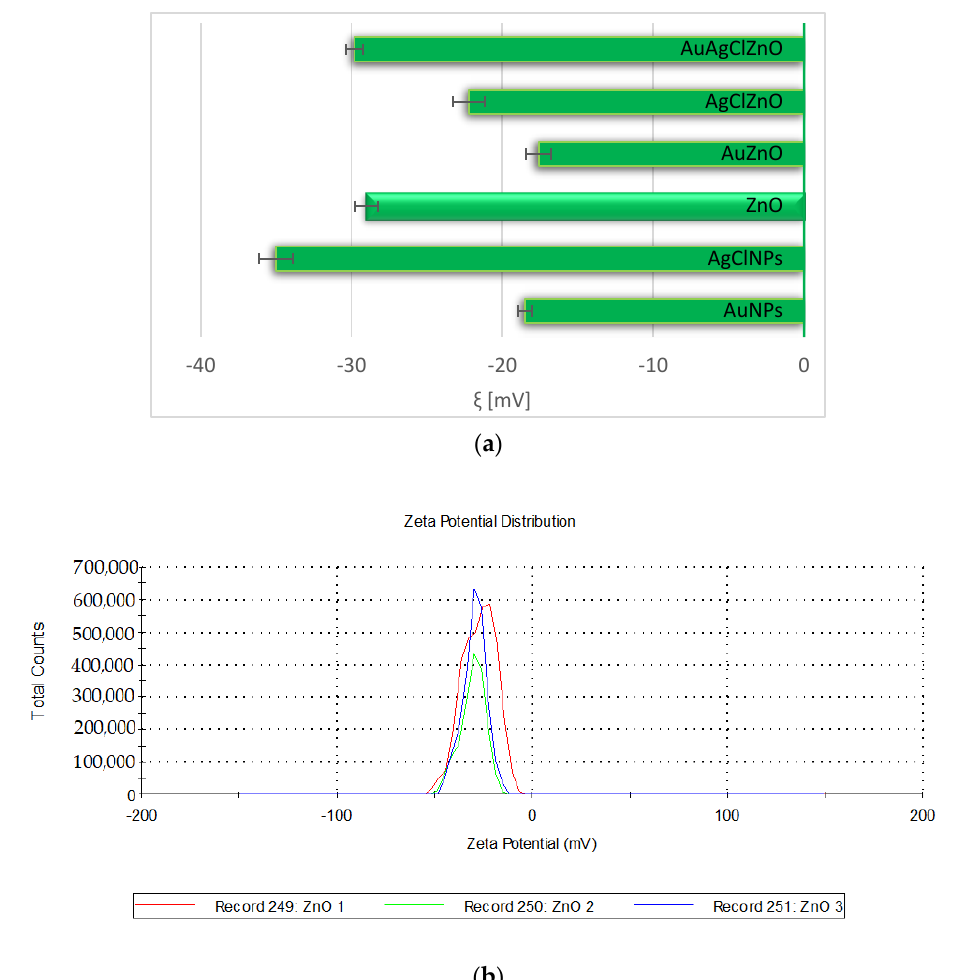
Figure 3. ( a ) Comparative presentation of the electrokinetic potential of samples; ( b ) The electrokinetic potential of ZnO sample.